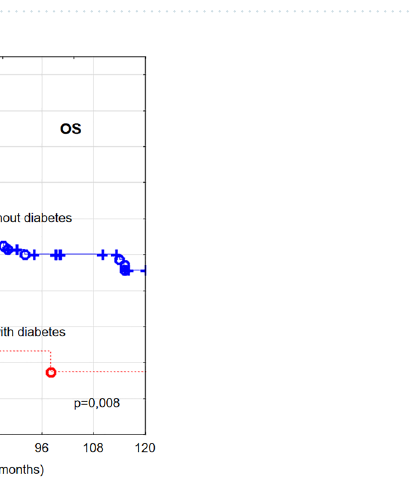
Figure 7. The probability of 5-year disease-specific survival (DSS) in T1 glottic cancer patients aged 70 and above in relation to diabetes.